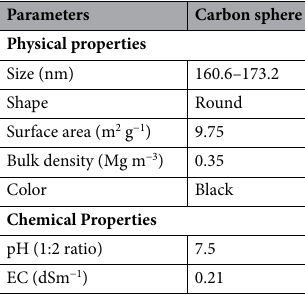
Table 1. Physical and chemical properties of carbon